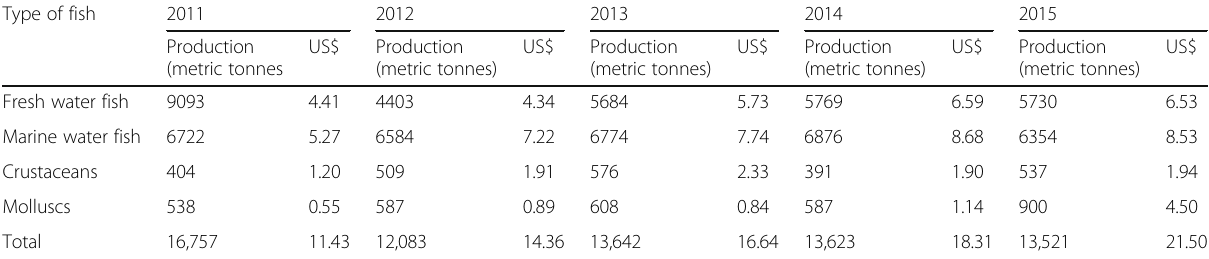
Table 8 Pastoral fish production in metric tonnes and value to fishermen in US$ (million); 1 US$ is equivalent to Kshs 100 Type of fish